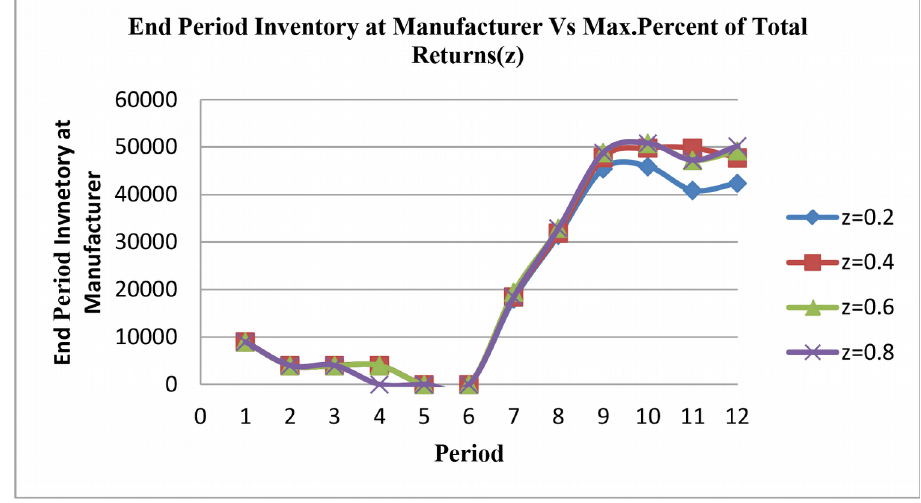
Figure 2. End Period Inventory at Manufacturer at multiple period